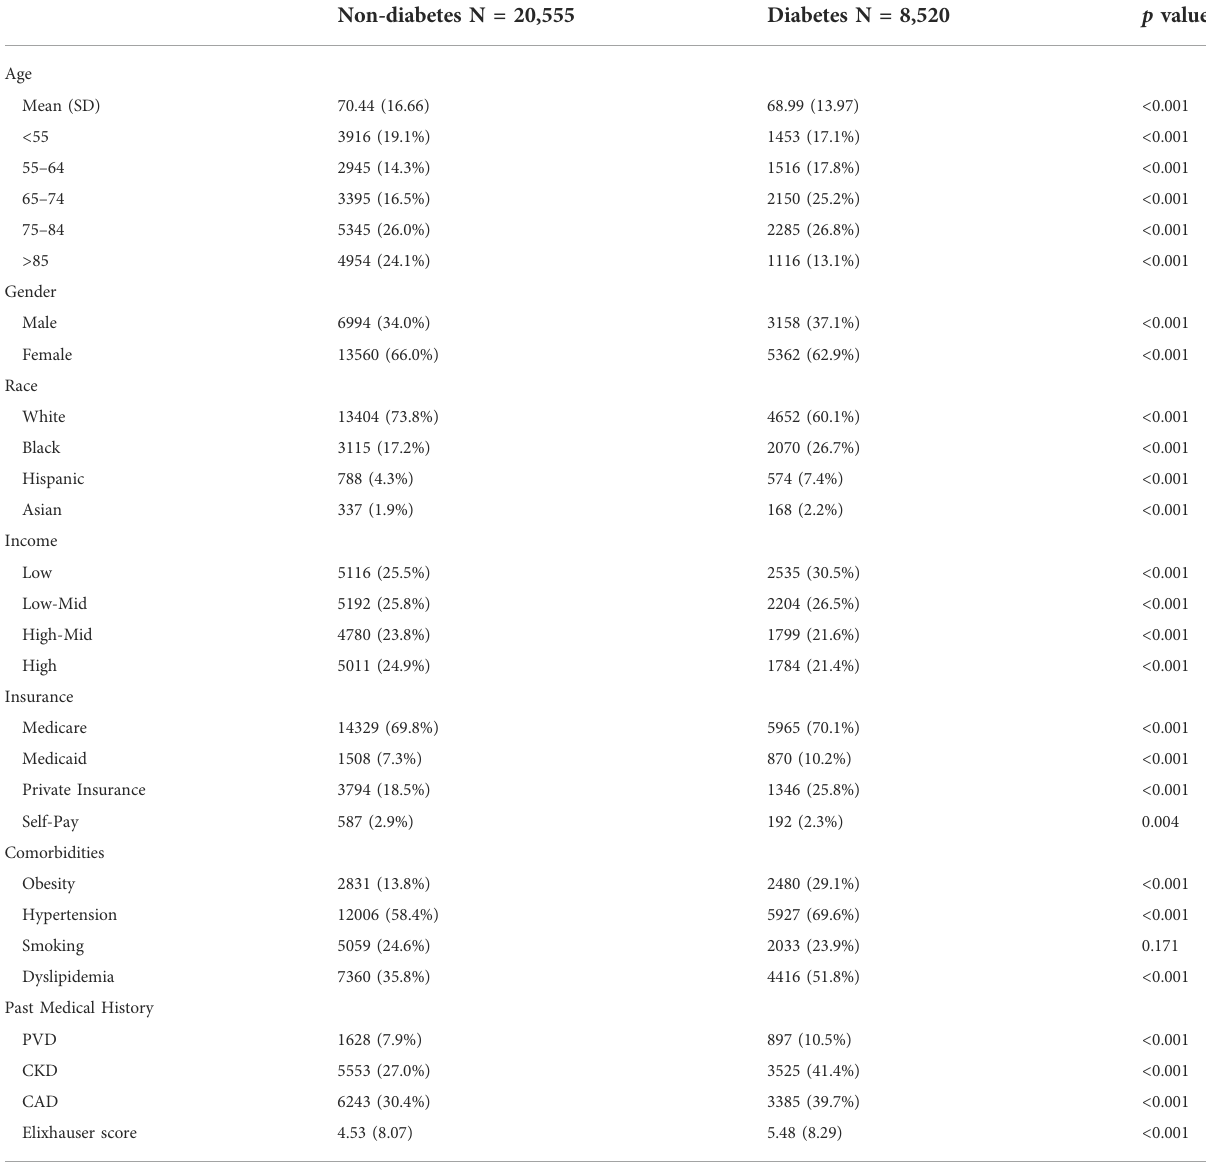
TABLE 2 Baseline characteristics of patients with heart failure and hypertrophic cardiomyopathy, with and without